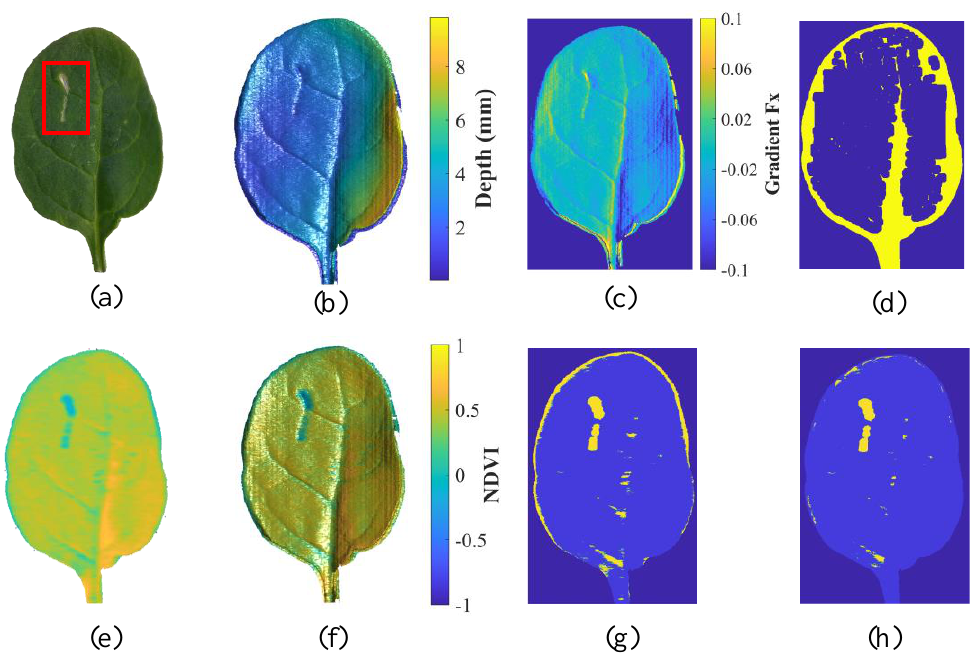
Figure 13. Defect detection on spinach leaves. ( a ) RGB image of leaf B with a defect; ( b ) reconstructed 3D geometry of leaf B; ( c ) depth gradient of leaf B; ( d ) Profile and vein of leaf B; ( e ) NDVI image ( f ) Reconstructed 3D geometry with NDVI value rendering; ( g ) results of KNN method; ( h ) marked defect. Pictures reprinted with permission from [55] © The Optical